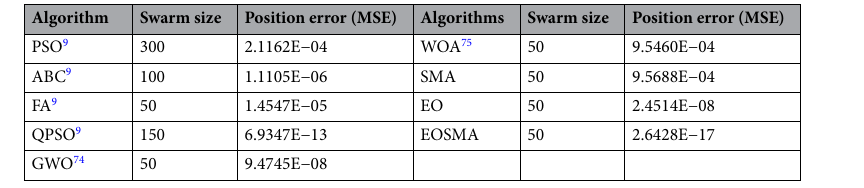
Table 6. Comparative results of inverse kinematics